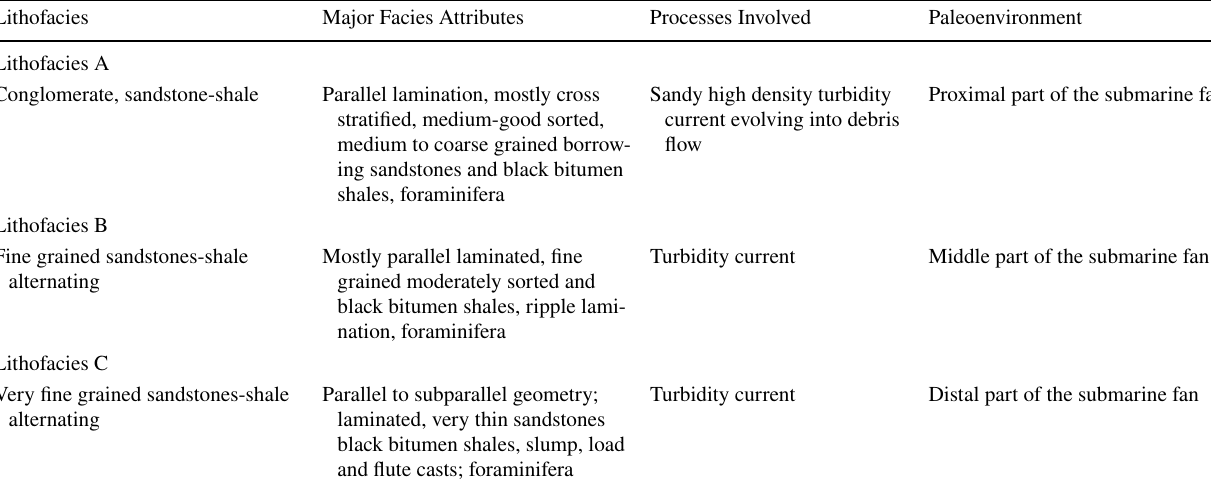
Table 1 Lithofacies A-B-C are given based on the lithology and structure of the Haymana Formation